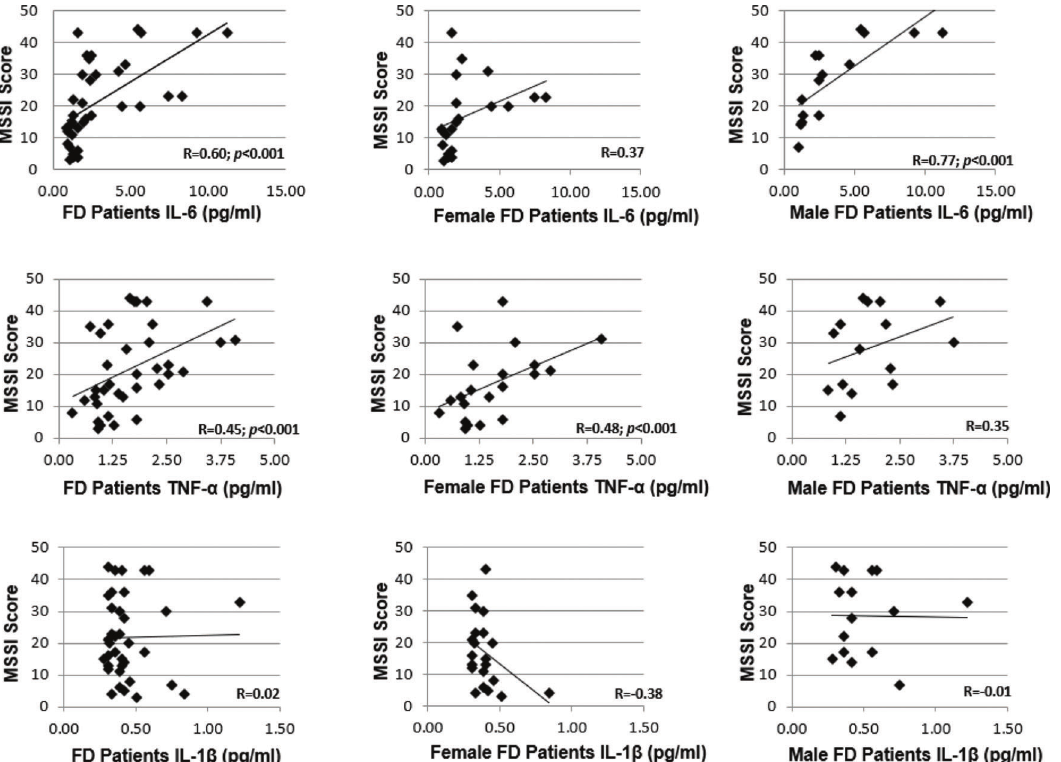
Figure 5 - Correlations between MSSI scores and serum cytokine levels in men and women with FD.